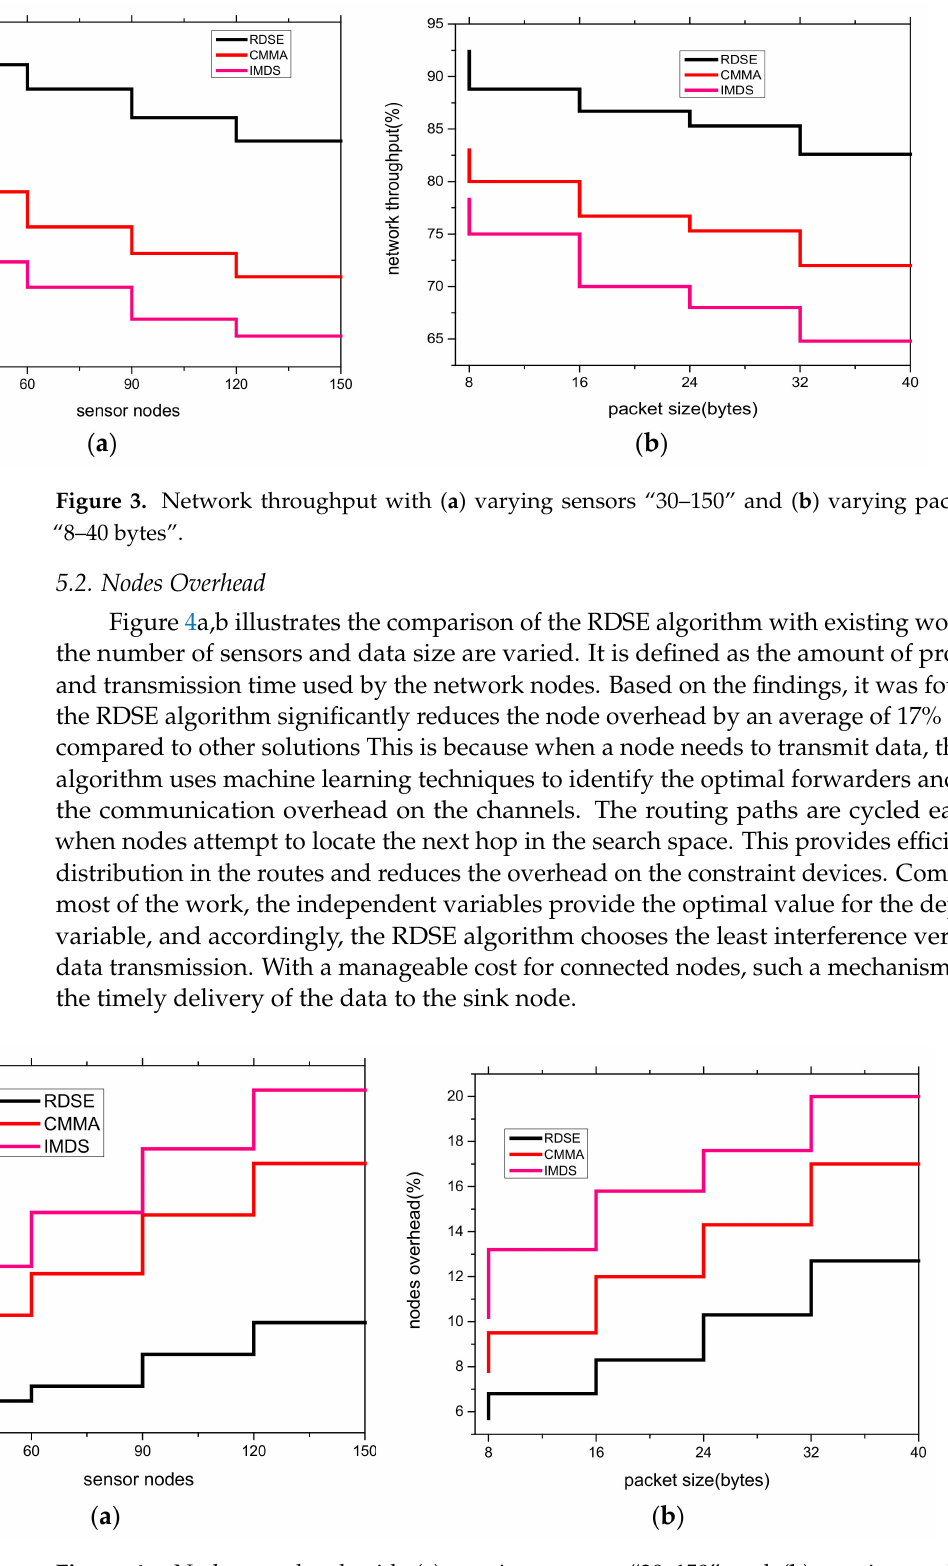
Figure 4. Nodes overhead with ( a ) varying sensors “30–150” and ( b ) varying packet sizes “8–40